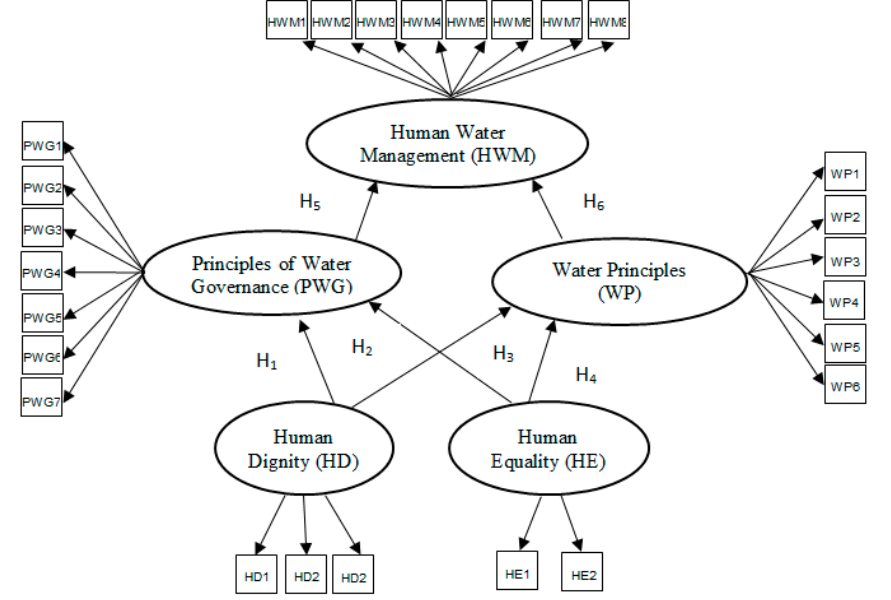
Figure 2. Human Water Management (HWM): a model to improve the living conditions of informal